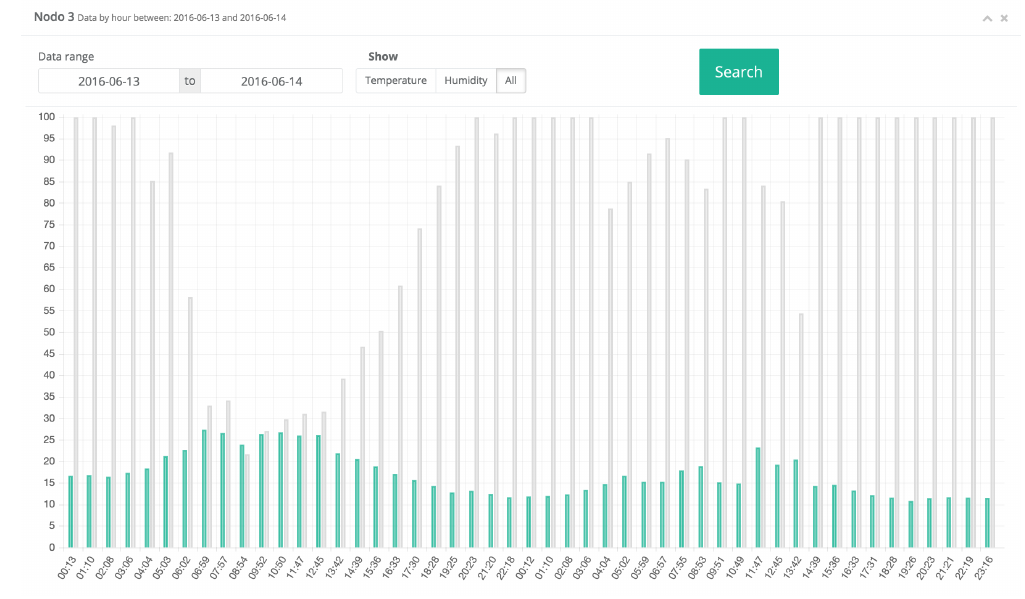
Figure 13. Data collected on node 3 on 13–14 June 2016.